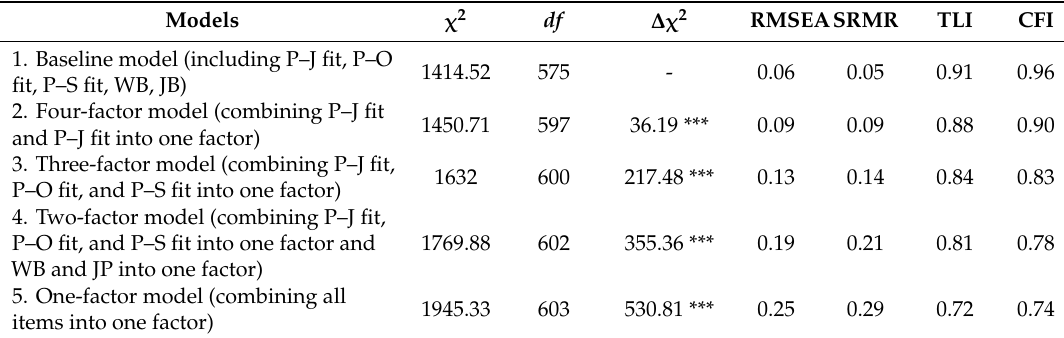
Table 2. Measurement model test.